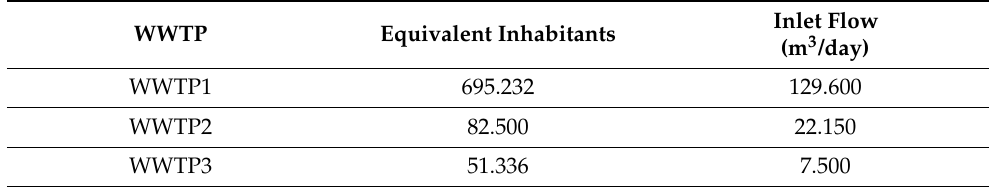
Table 2. Main characteristics of studied